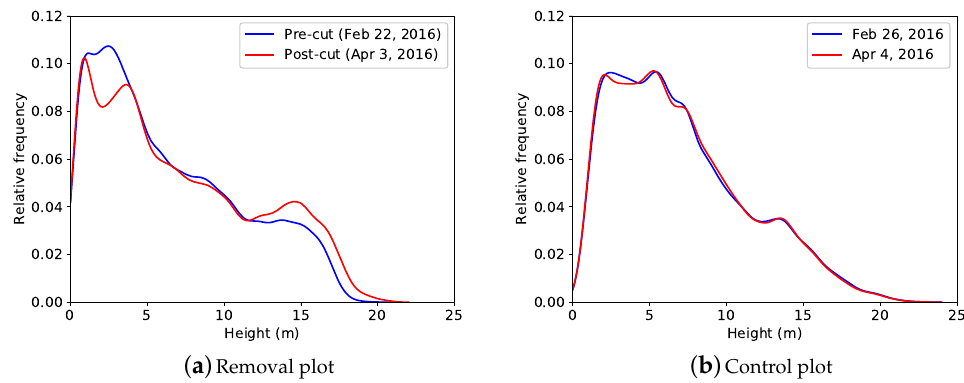
Figure 5. Comparison of frequency distribution with Gaussian kernel density estimation of all vertical returns combined for the bi-temporal TLS data from the removal ( a ) and control plot ( b ).